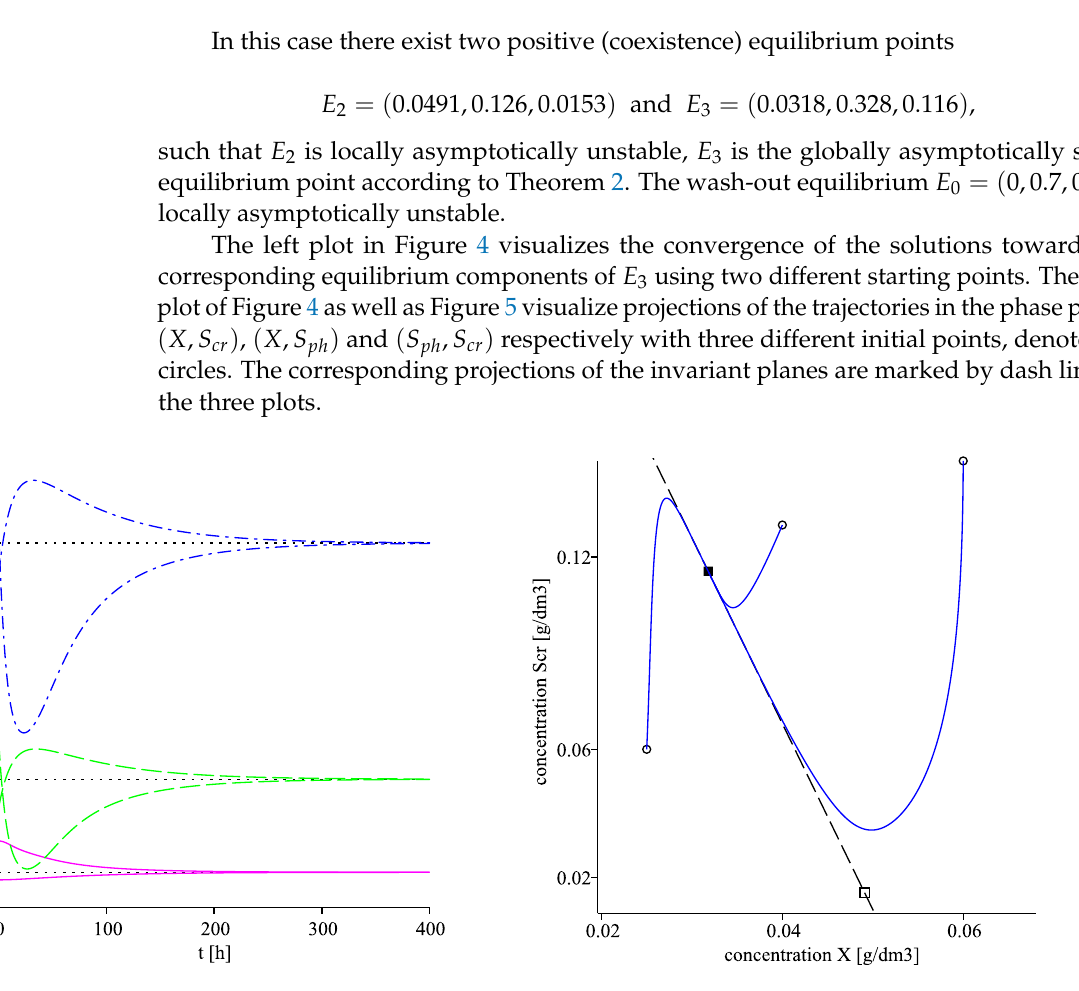
Figure 4. D = 0.08. ( Left ): time evolution of solutions X (solid line), S ph (dash-dot line) and S cr (dash line); the horizontal dot lines pass through the corresponding components of the equilibrium point E 3 . ( Right ): projections of the trajectories in the ( X , S cr ) -phase plane with three different initial points, denoted by circles. The corresponding equilibrium components of E 3 are marked by a solid box, of E 2 are denoted by a box. The dash line presents the a projection of invariant plane S cr + k cr X = S 0 cr